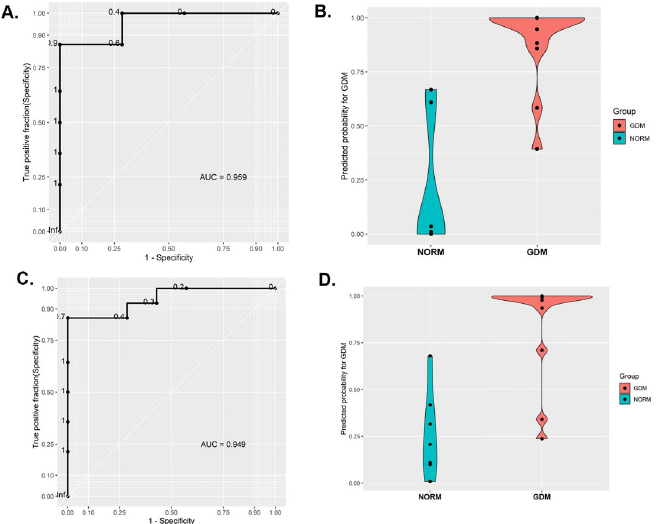
Fig 8. Receiver operator characteristics (ROC) curve for gestational diabetes GDM early gestation prediction. (A&C) Receiver operator characteristic (ROC) curve generated using miRNAs isolated from plasma derived EVs of first trimester of pregnancy with GDM (n = 14) versus normal pregnancy (n = 7). ( B&D ) violin plot of predicted probability for GDM with 0 = low probability and 1 = high probability in normal (NORM) and GDM. ( A,B = approach using all miRNAs detected in GDM, C,D = approach using differentially expressed genes